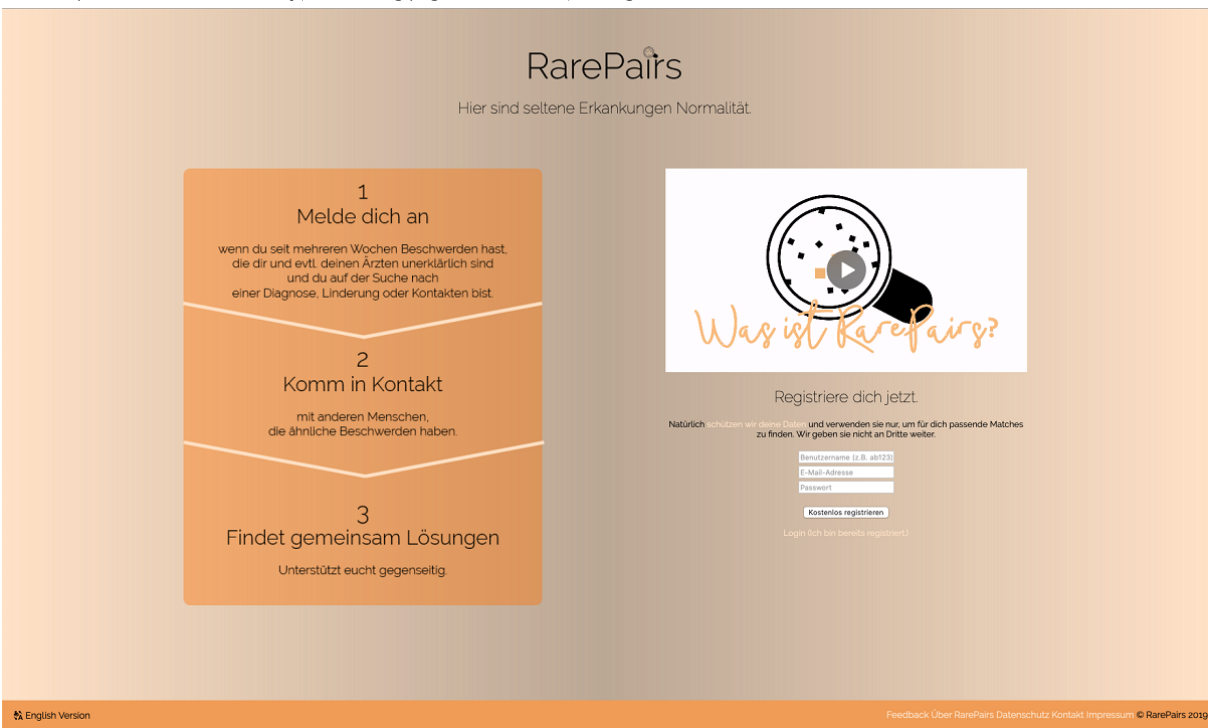
Figure 3. Landing page of RarePairs where users can get information, register, or log in. Users find information by text and a short video